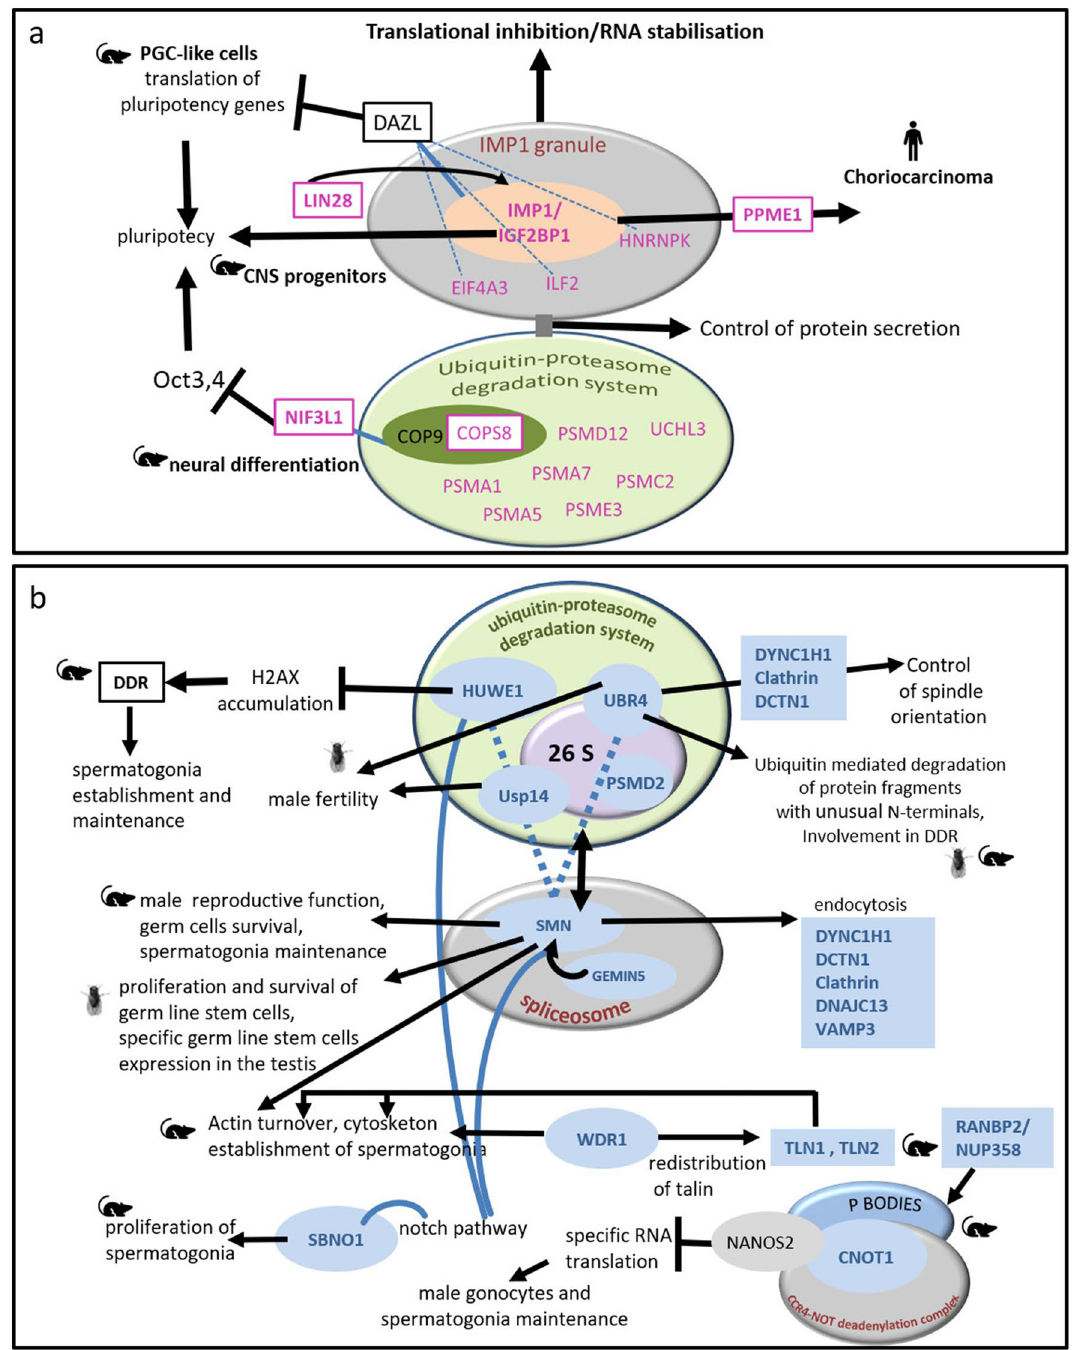
Figure 4. Crosstalk of pathways involving orthologs of chicken proteins preferentially abundant in chicken female ( a ) and male ( b ) PGCs based on the literature (for references see Sects. 3.6 and 3.7). Proteins in pink and blue correspond to the orthologs of proteins identified as overabundant in chicken female and male PGCs respectively. Pointed and blunted arrow heads represent activation and inhibition